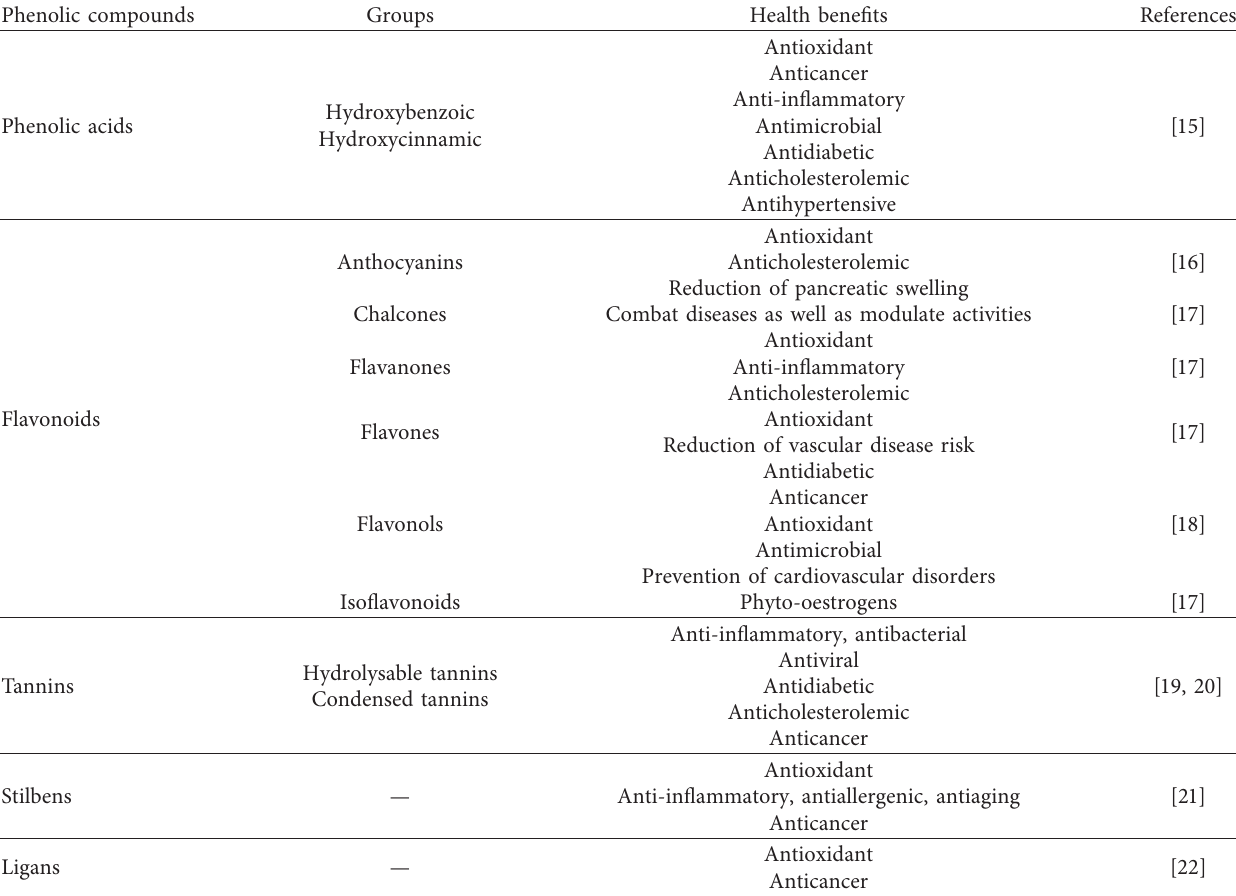
Table 2: Classification of phenolic compounds and their health